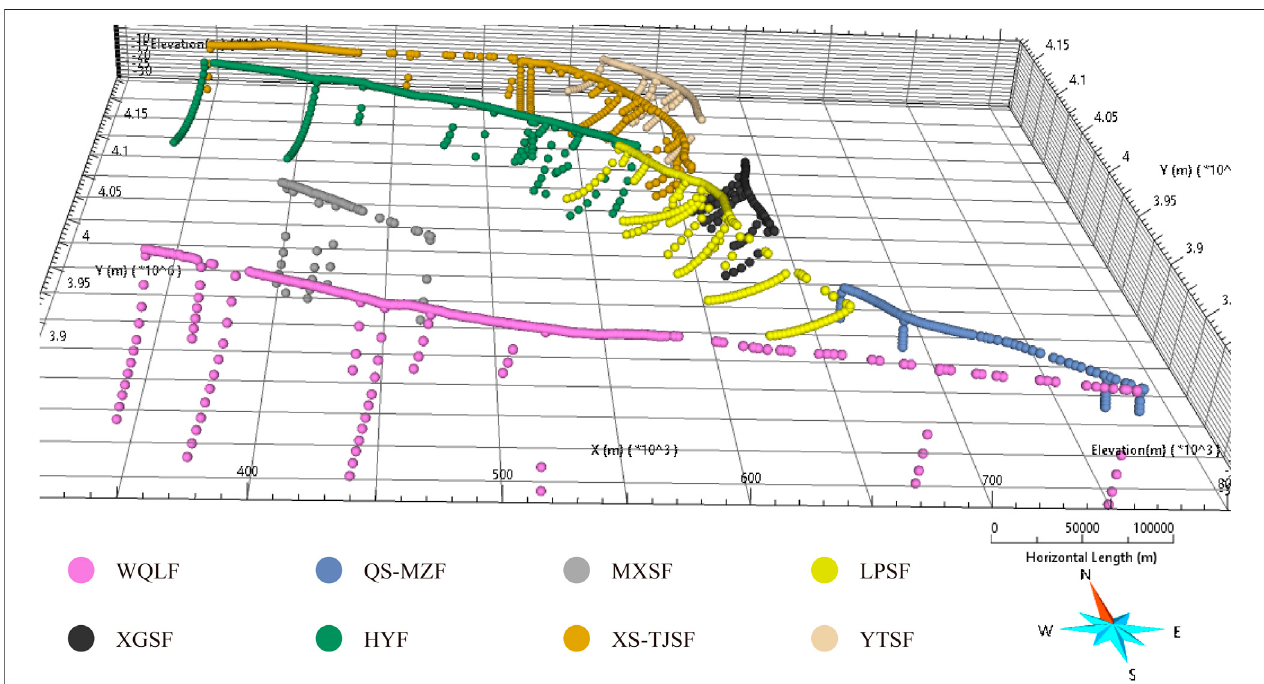
FIGURE 3 | 3D point set of the V3 model in SKUA-GOCAD software. The control points of different faults are represented by different colored spheres.